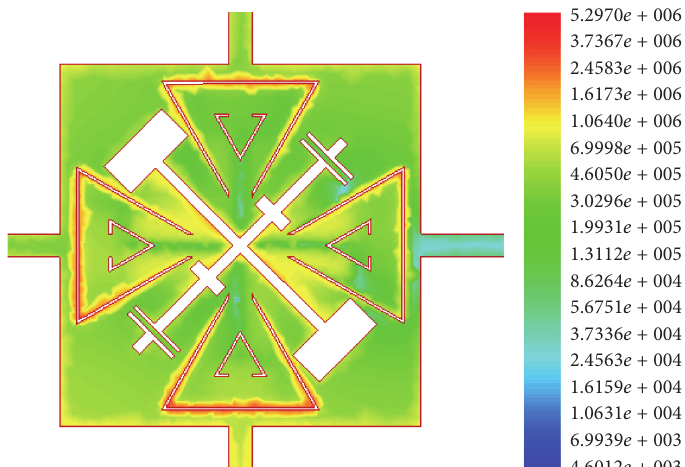
Figure 5: Current distribution of the coupler for 5.9 GHz.